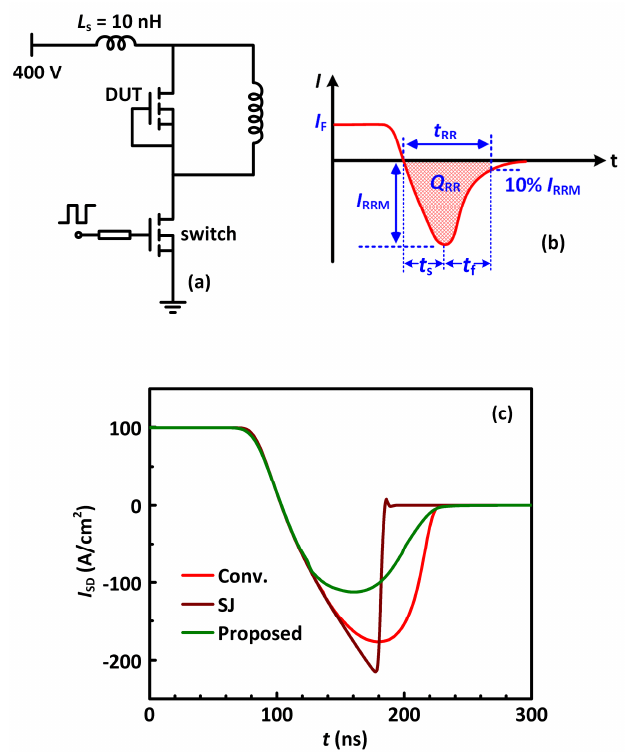
Figure 9. ( a ) Test circuit configuration for the reverse recovery characteristics. ( b ) Schematic of reverse recovery waveforms. ( c ) Reverse recovery characteristics of the studied MOSFETs.